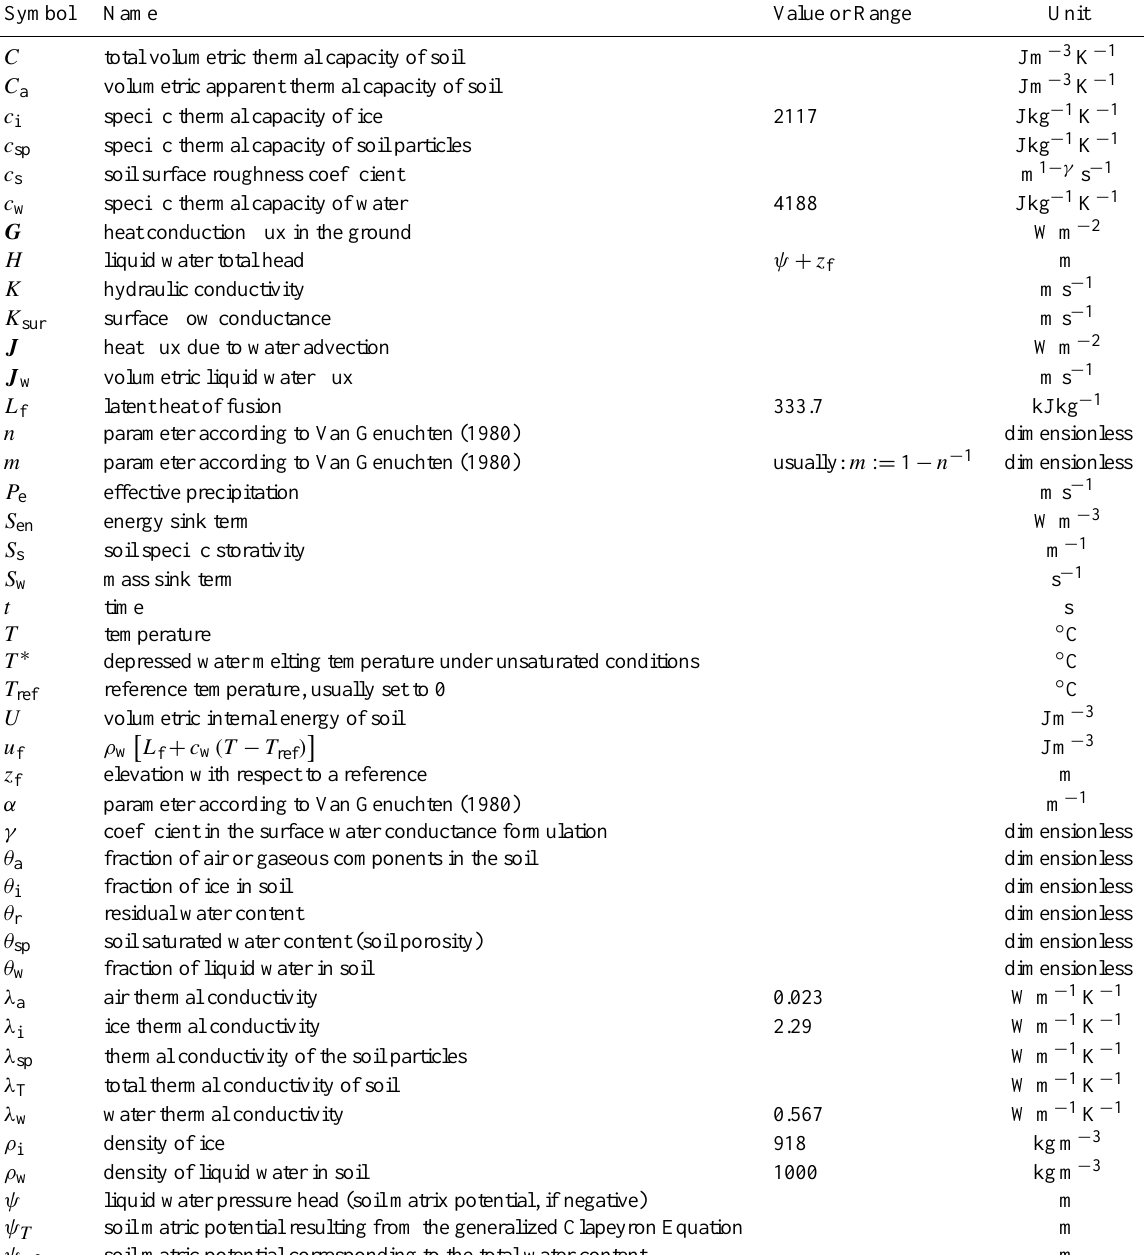
Table D3. Table of symbols for soil balance and surface and subsurface water flow equations.